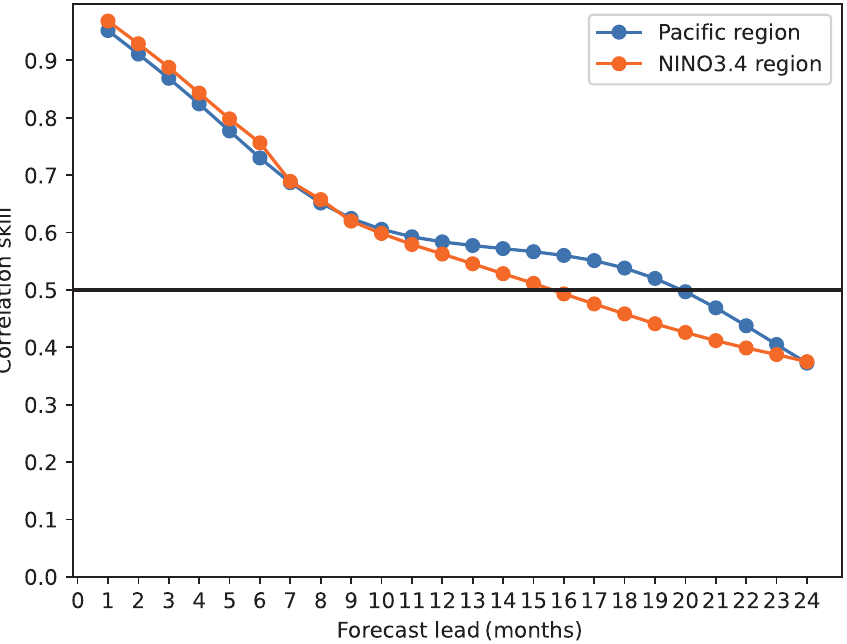
Figure 5. Comparison of the ENSO correlation skill with the different prediction regions.